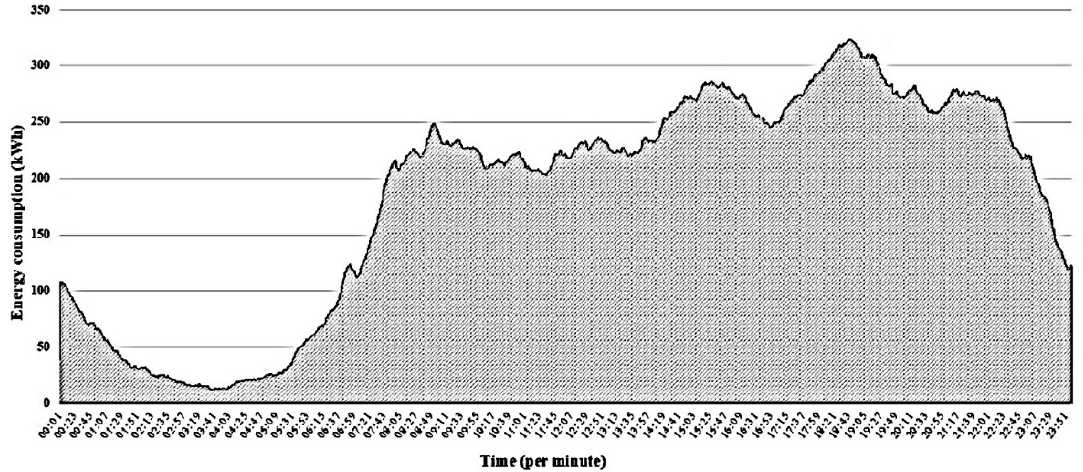
Figure 16. Energy consumption of a random day (March 2018) for each minute.